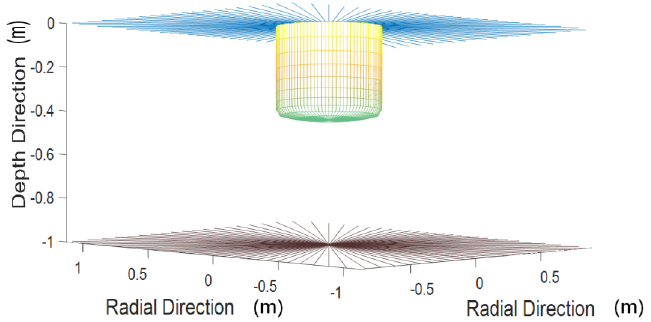
Figure 4. Illustration of the computational mesh in the near field. For clarity only the radial lines of the mesh on the free surface and on the bottom surface under the floater are shown.